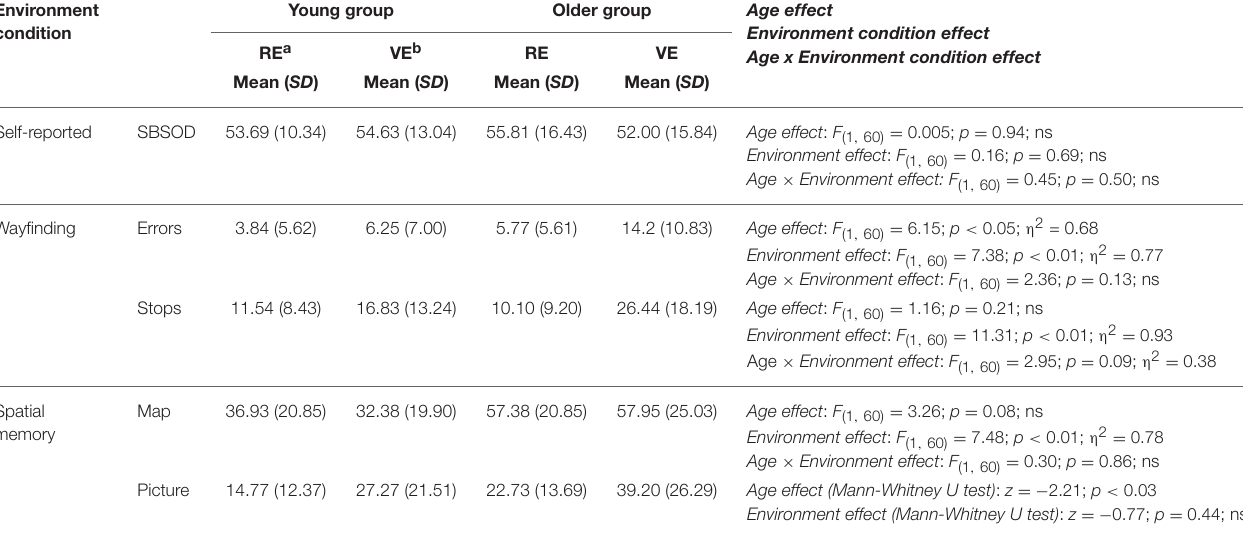
TABLE 3 | Scores of the participants for self-reported (from Santa Barabara Sense of Direction Scale, SBSOD) and direct navigation performance. Environment condition